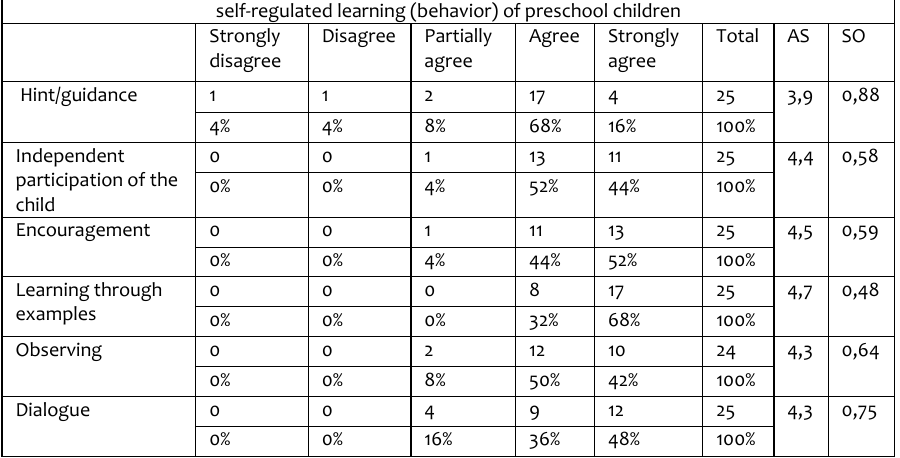
Table 1 : Which approaches are the most useful to you for the encouragement of self-regulated learning of preschool children? We have shown the most frequent answers regarding the approaches for developing/encouraging self-regulated learning (behavior) of preschool